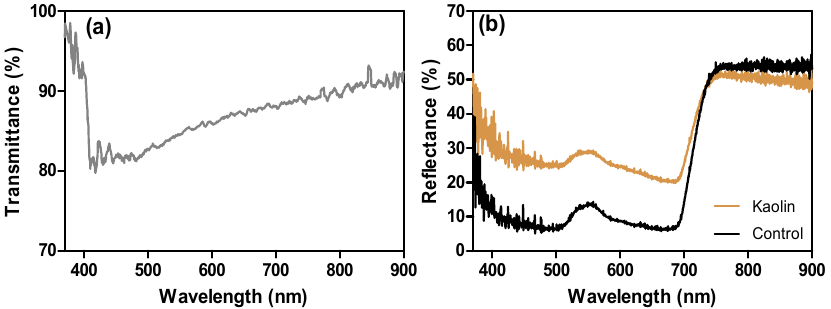
Figure 4. Transmittance (%) spectrum ( a ) of a kaolin suspension (5% w / v) and reflectance (%) spectra ( b ) of leaves with and without kaolin (control) ( n = 3).